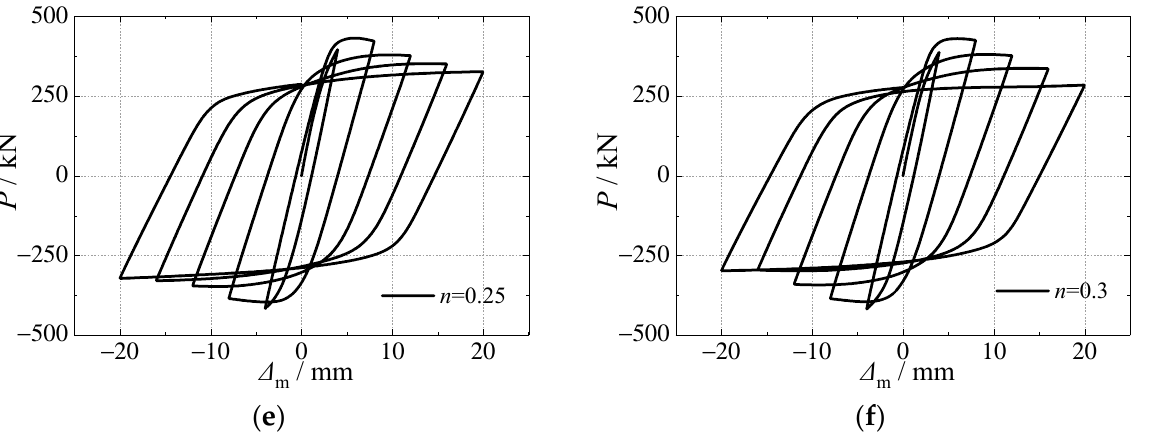
Figure 19. Effect of axial load ratio on hysteretic curve. ( a ) n = 0.05; ( b ) n = 0.10; ( c ) n = 0.15; ( d ) n = 0.20; ( e ) n = 0.25; ( f ) n = 0.30.